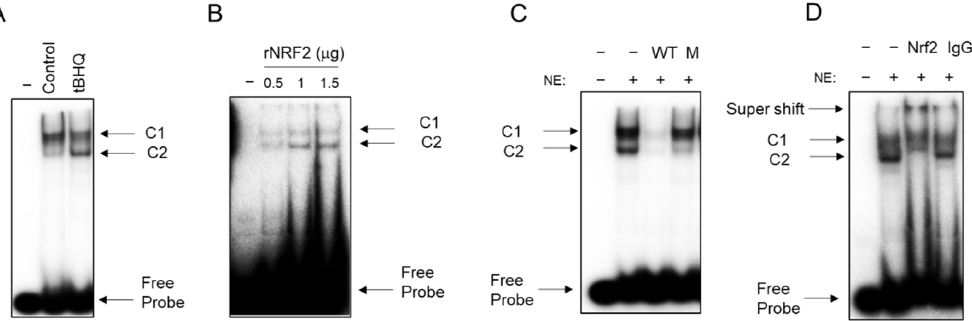
Figure 5. EMSA of CSE putative ARE binding complexes in response to tBHQ treatment. Nuclear extracts (6 µg) from control and SAE cells treated with tBHQ (25 µM) for 15 h were used in EMSA. Two DNA–protein complexes, C1 and C2, are detected in control cells. C2 binding is further increased by tBHQ treatment ( A ). Similar complex formation is observed with purified recombinant NRF2 (rNRF2) ( B ). Competition assay using wild type (WT) and mutant (M) oligos (50×) and nuclear extracts of tBHQ-treated SAE cells ( C ). Super-shift assay with specific anti-NRF2 antibody and control IgG using nuclear extracts of tBHQ-treated SAE cells ( D ).